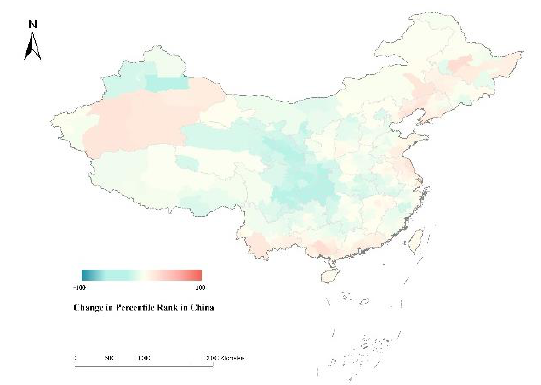
Figure 7. Spatial distribution of changes in PM 2.5 PR between 2010 and